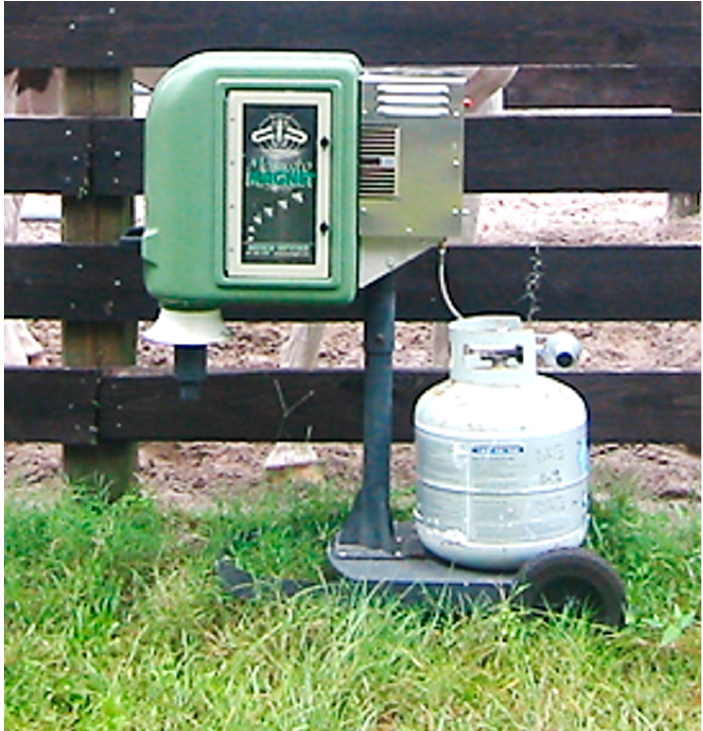
Figure 3. Mosquito Magnet-Pro (MM-Pro) trap placed next to the gate of a 3 × 3 m horse feeding stall. The attracted mosquitoes are sucked into a collection net inside the trap shell where they dehydrate and die. The MM-Pro is 2 m high and constructed of stainless steel with a PVC shell.